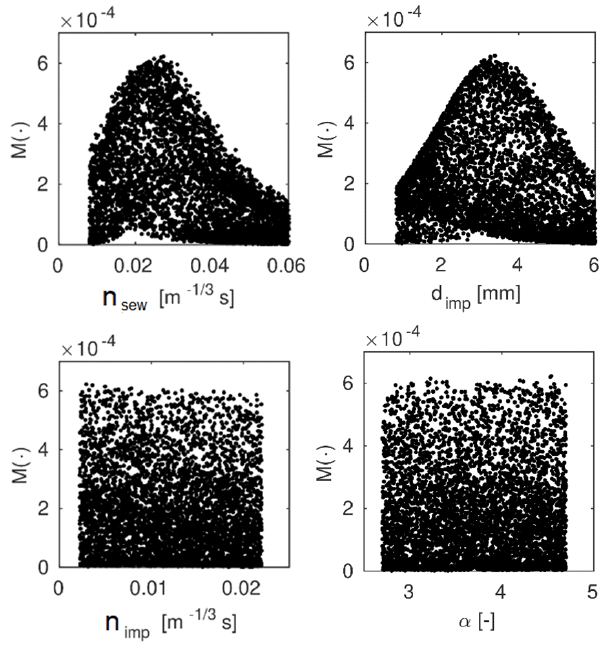
Figure B3. Calculated likelihood function – scatter plots of M val- ues versus calibrated catchment parameters in